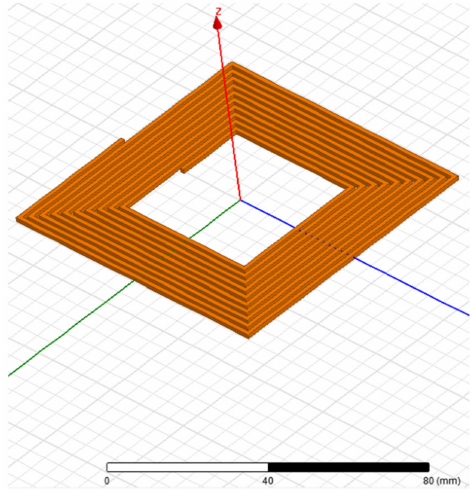
Figure 5. Reference rectangular coil